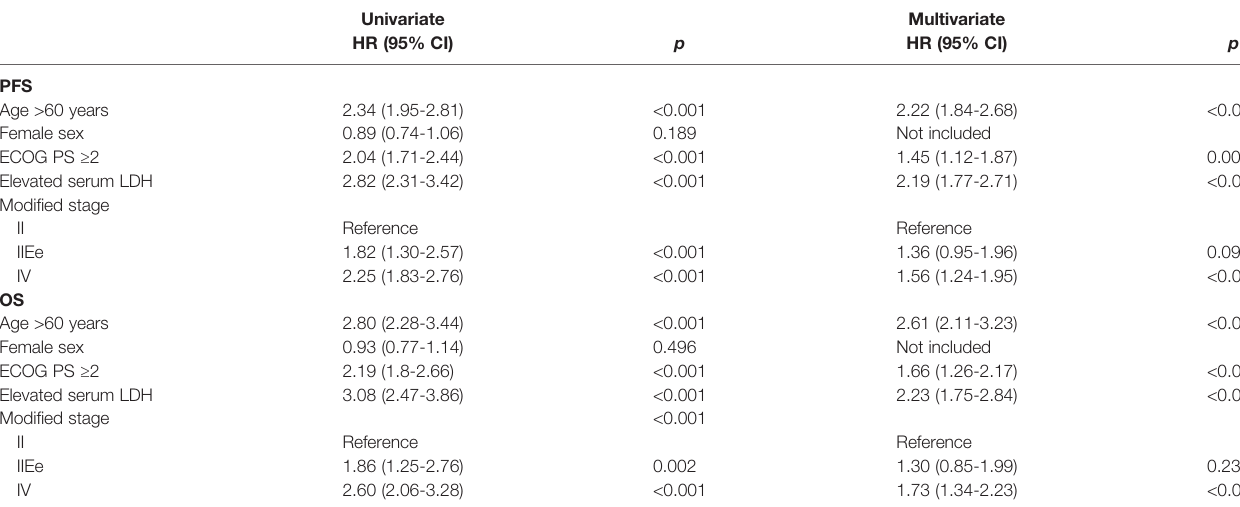
TABLE 2 | Univariate and multivariate prognostic